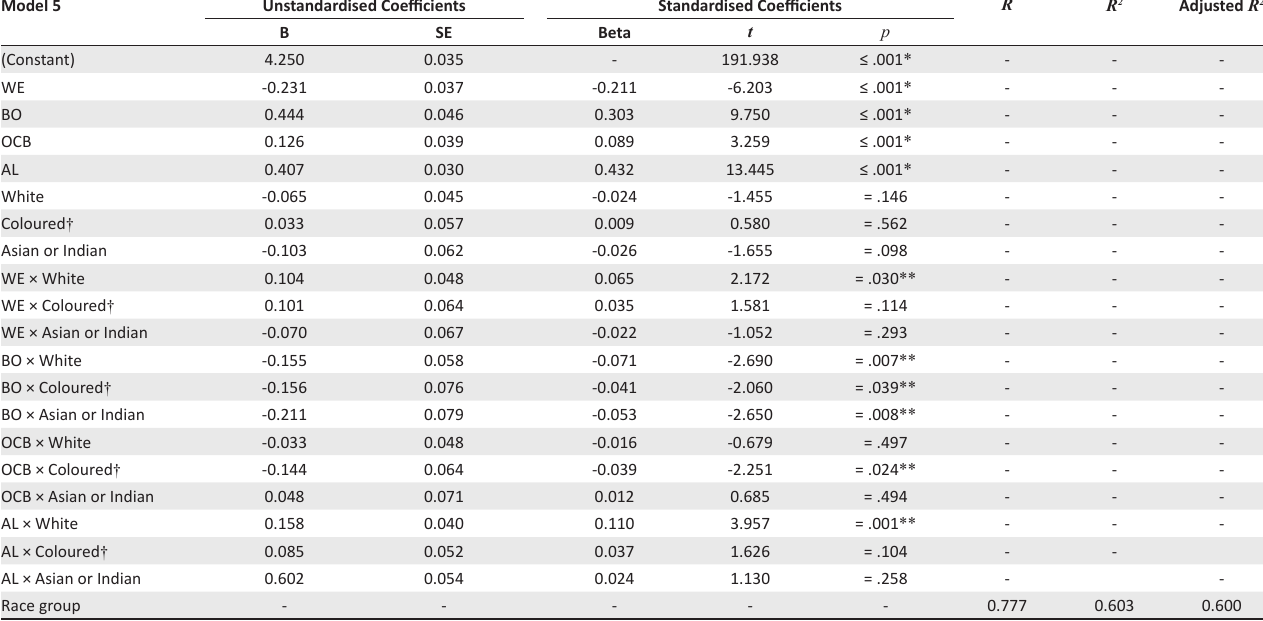
TABLE 3: Moderated multiple regression in terms of race